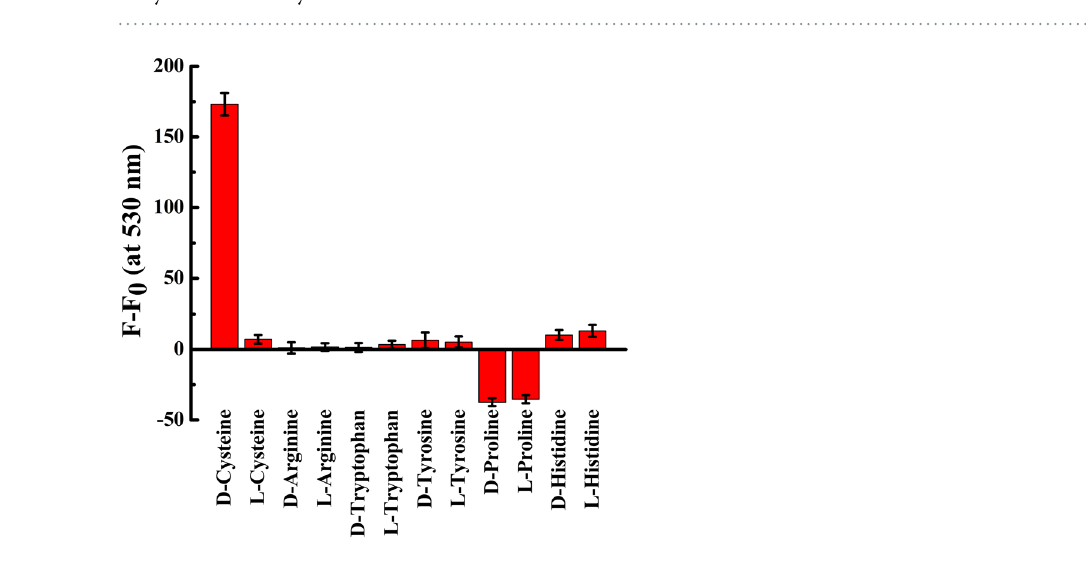
highest and distinct from L-cysteine. All α -amino acids consist of a carboxylic acid and an amino functional group. However, cysteine is distinctive from the rest due to the presence of its thiol group. Considering that a chiral CdTe QD was employed in the proposed assay, the key role of the thiol group in the differentiation of L- and D-cysteine is evident. In fact, both D- and L-cysteine are bonded to the surface of QDs through S-Cd bond,